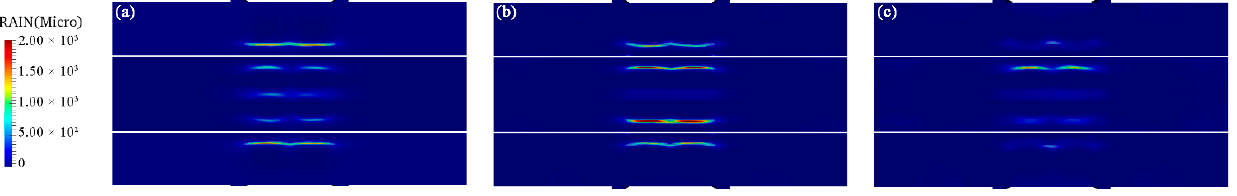
Figure 9. The corrosion-induced strain on the beam surface under different loading conditions (sur- face cracking moment): ( a ) S-L00, ( b ) S-L30, and ( c )